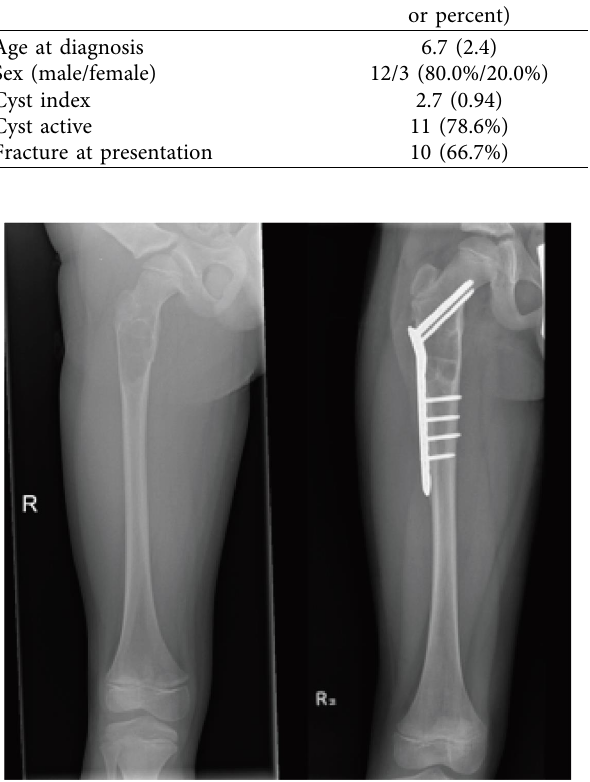
Figure 1: Preoperative images (medial and lateral) of a patient who received open reduction and internal fxation with bone substitute injection.